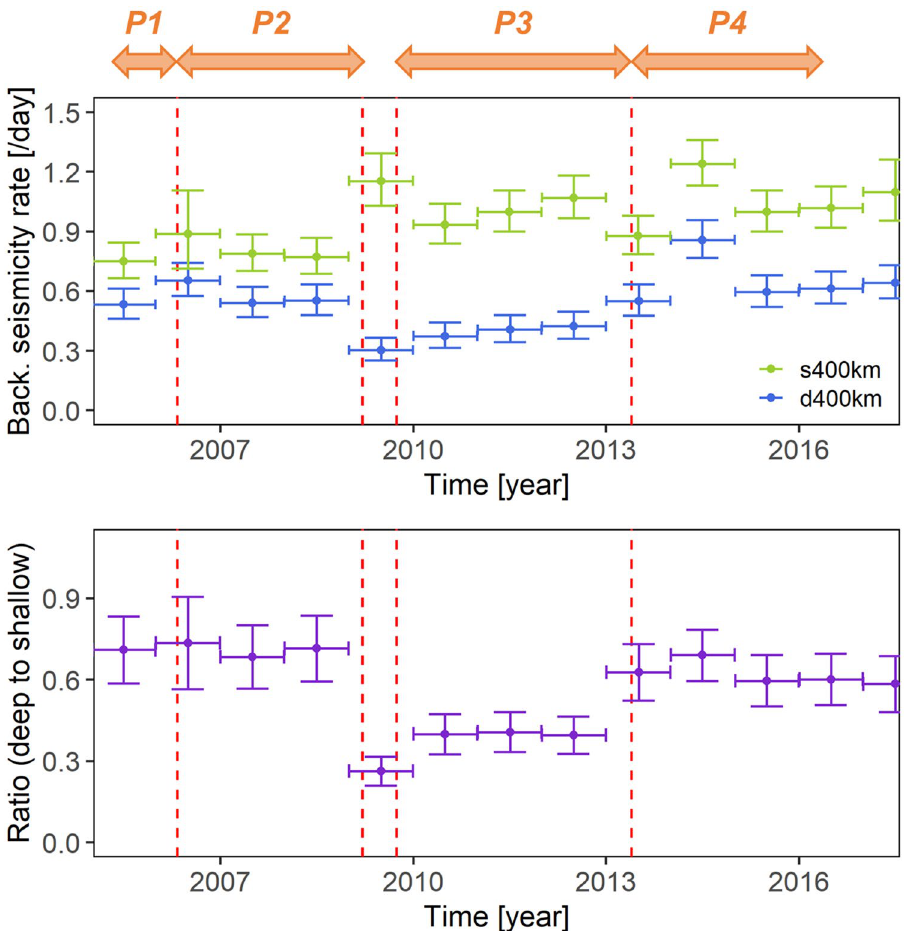
Figure 5. (Top) Temporal evolution of the background seismicity rate µ for earthquakes, with focal depths shallower than 400 km (s400km) and deeper than 400 km (d400km), as obtained from Epidemic-Type Aftershock Sequence (ETAS) analysis. The vertical error bars represent 95% confidence intervals. As in the lower panel of Fig. 2, the red vertical broken lines indicate the time of the large earthquakes. The four periods, P1, P2, P3, and P4, are shown by the orange arrows for reference. (Bottom) Temporal evolution of the ratio of the background seismicity rate µ for the deeper earthquakes (d400km) to that for the shallower earthquakes (s400km). Figures generated with R 3.x (https ://www.r-proje